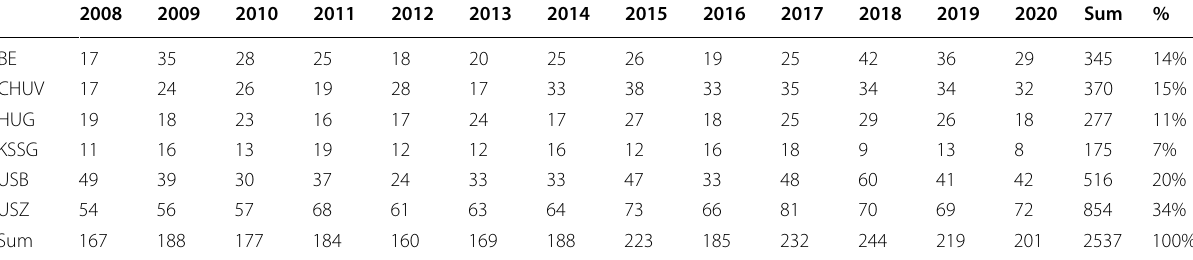
Table 1 Number of kidney transplantations (deceased donors) per year and transplantation center